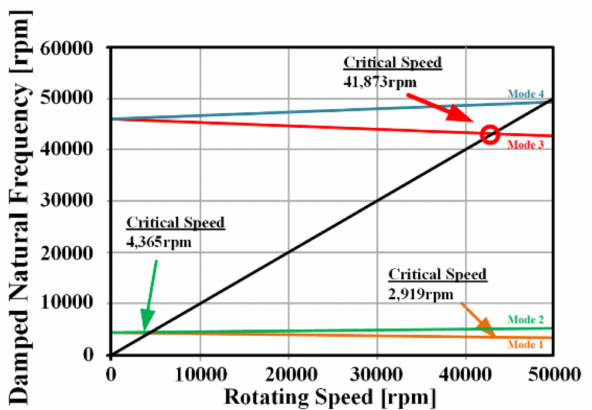
Figure 2. Critical speed analysis of STS420-J2 shaft rotor.